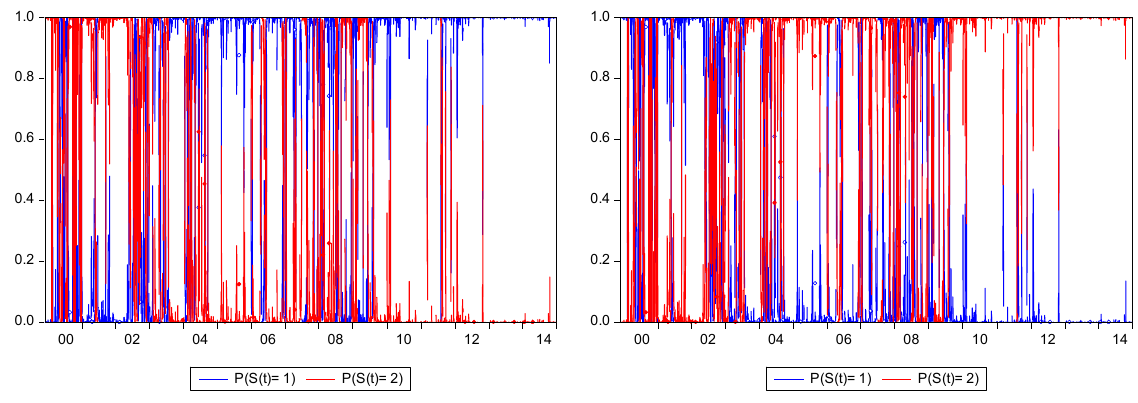
Figure 4. Shows the robustness results of the Markov-switching approach. P ( s t = 1 indicates regime one; P ( s t = 2 indicates regime two.